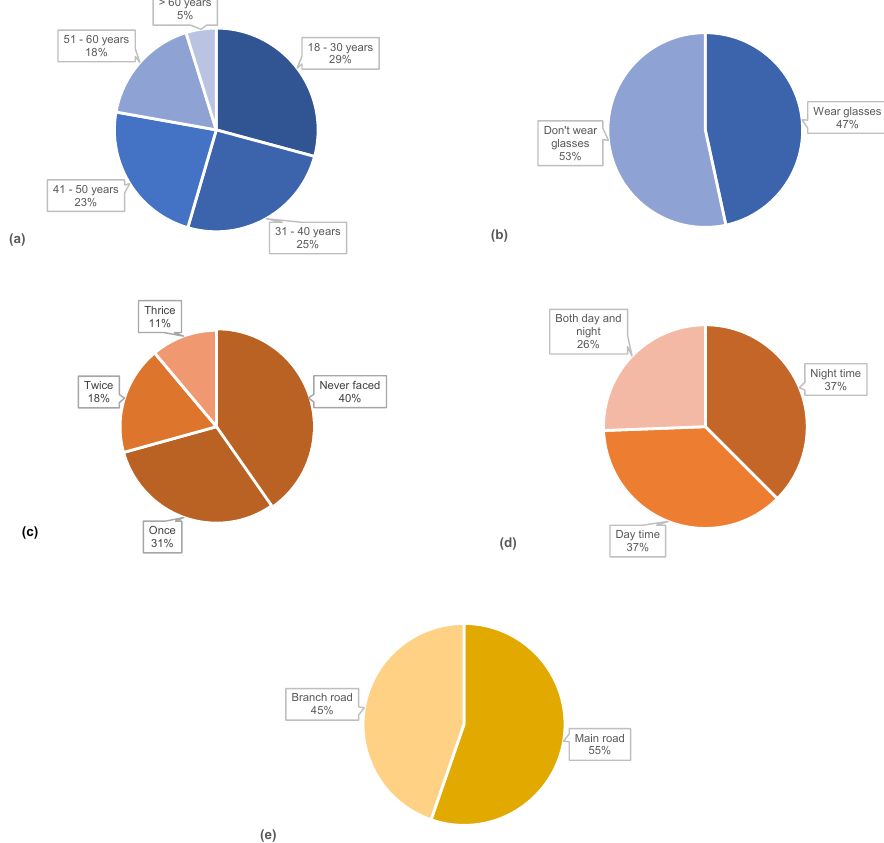
Figure 4. Descriptive statistics of the questionnaire survey: ( a ) age groups, ( b ) drivers wearing glasses, ( c ) drivers who experienced road crashes, ( d ) time the crash occurred, and ( e ) type of road on which the crash occurred.